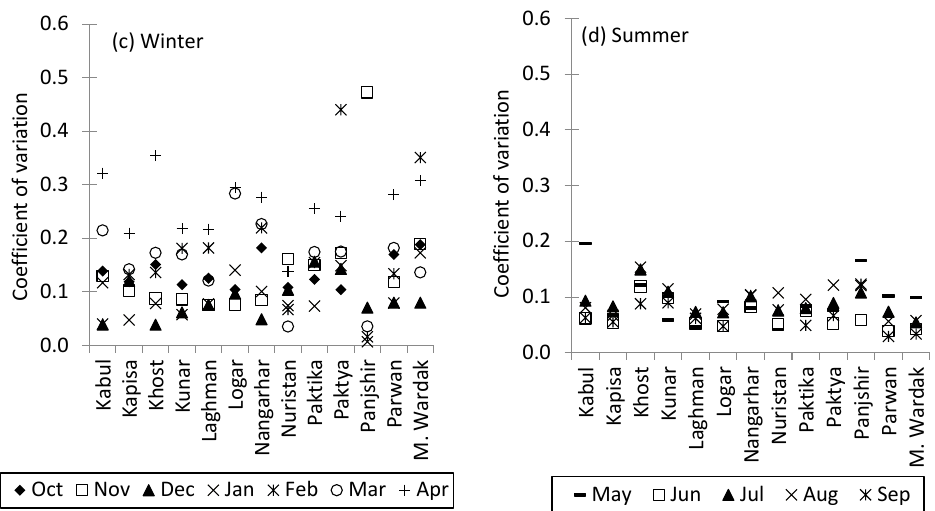
Figure 9. Coefficient of variation of mean actual evapotranspiration at the spatial administrative units of ( a ) and ( b ) inter and intra sub-basin and ( c ) and ( d ) provincial level.